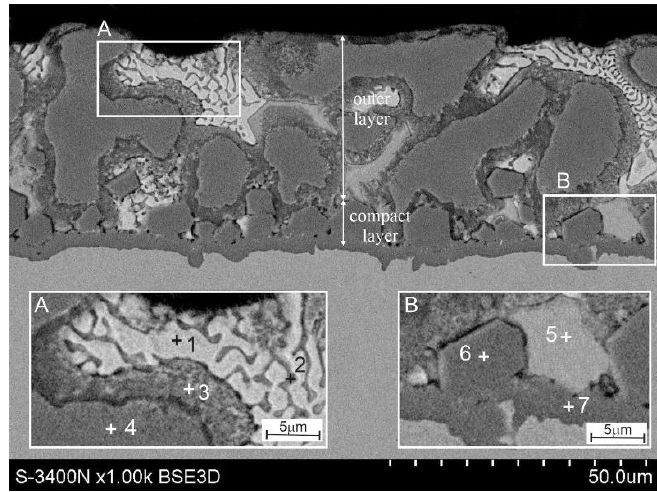
Figure 3. SEM microstructure of the coating obtained in the ZnAl23Mg3Si0.4 bath. Table 4. Chemical composition in the micro-areas (EDS) of the coating obtained in the ZnAl23Mg3Si0.4 bath (analysis points as shown in Figure 3).